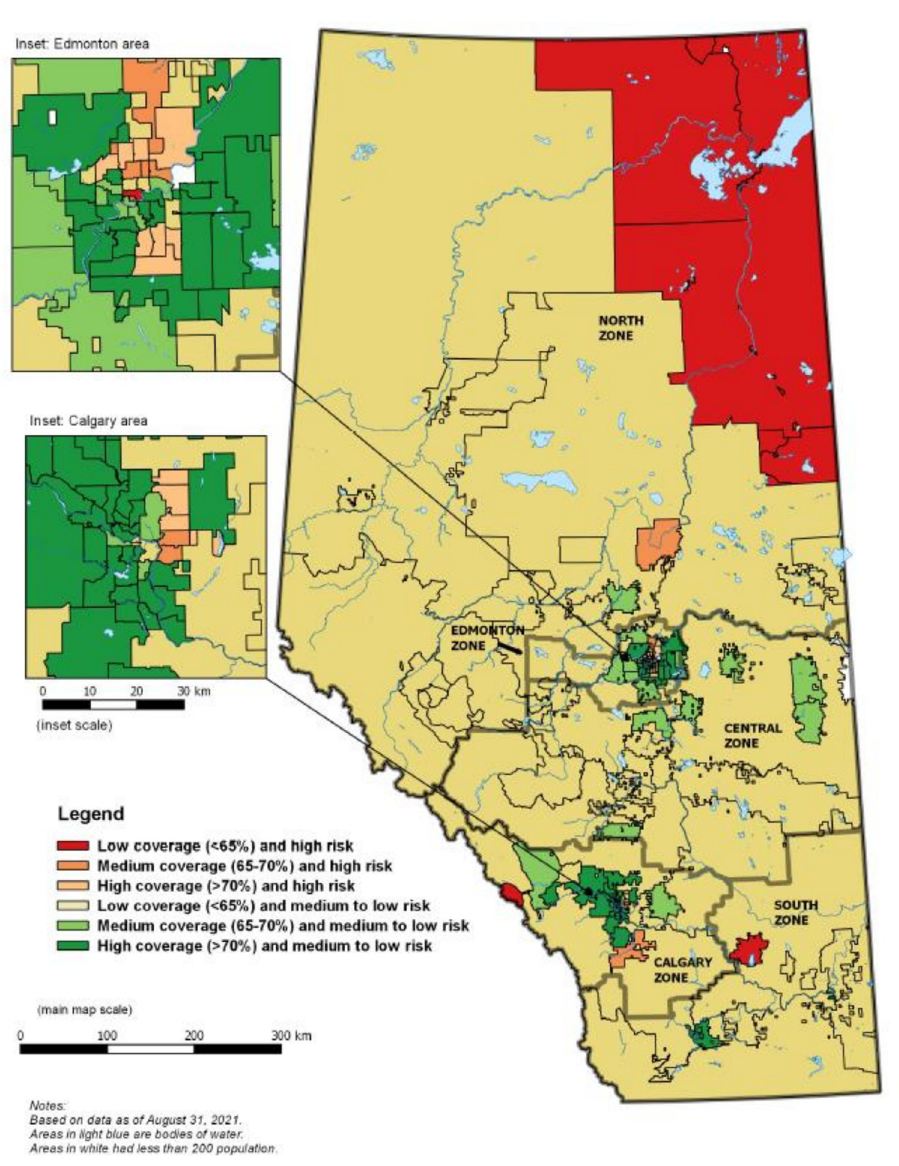
Fig 1. Map of Alberta forward sortation areas (FSAs) showing COVID-19 vaccination coverage and neighborhood risk quintile. Note : This map was created using Alberta FSA boundary file as a base map by linking with vaccine coverage and neighborhood level COVID-19 risk quintile using QGIS software. Use of this product is governed by the Statistics Canada Open License Agreement which provides permission for a “worldwide, royalty-free, non-exclusive license to use, reproduce, publish, freely distribute, or sell the information”